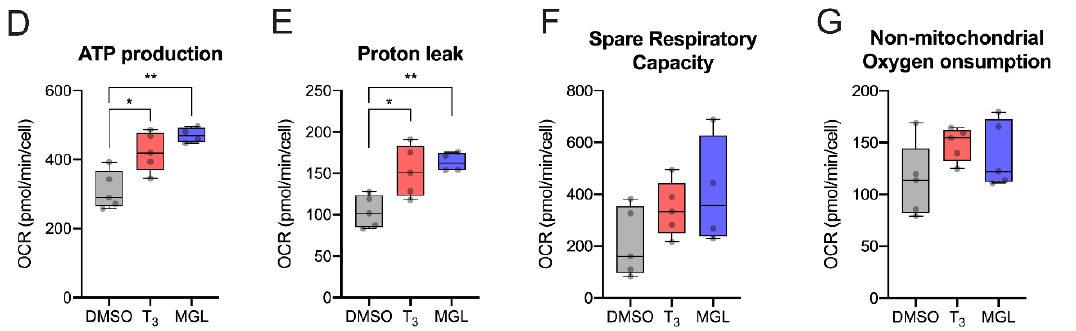
Figure 5. MGL-3196 increases mitochondrial activity in OATP1B1-expressing cells: ( A ) measurement of oxygen consumption rate (OCR) in HEK-1B1 cells treated for 48 h with T 3 (100 nM) or MGL-3196 (6 µM) (n = 5 biological replicates per group); ( B ) basal OCR ([last rate measurement before oligomycin injection] − [non-mitochondrial respiration rate]); ( C ) maximal respiration ([maximum rate measured after FCCP injection] − [non-mitochondrial respiration rate]); ( D ) ATP production ([last rate measurement before oligomycin injection] − [minimum rate measured after oligomycin injection]); ( E ) proton leak ([minimum rate measured after oligomycin injection] − [non-mitochondrial respiration rate]); ( F ) spare respiratory capacity ([maximal respiration] − [basal respiration]); ( G ) non-mitochondrial oxygen consumption (minimum rate measured after rotenone/antimycin A injection). One-way ANOVA with Tukey’s post hoc test: ns = not significant; * p < 0.05, ** p < 0.01. FCCP, carbonyl cyanide-p-trifluoromethoxyphenylhydrazone; rot., rotenone; AA, antimycin A.